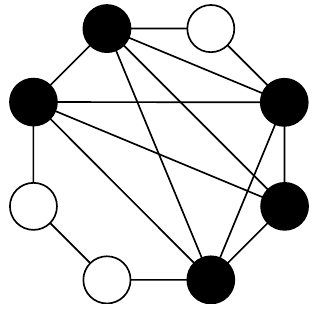
Figure 2. DAEN model.